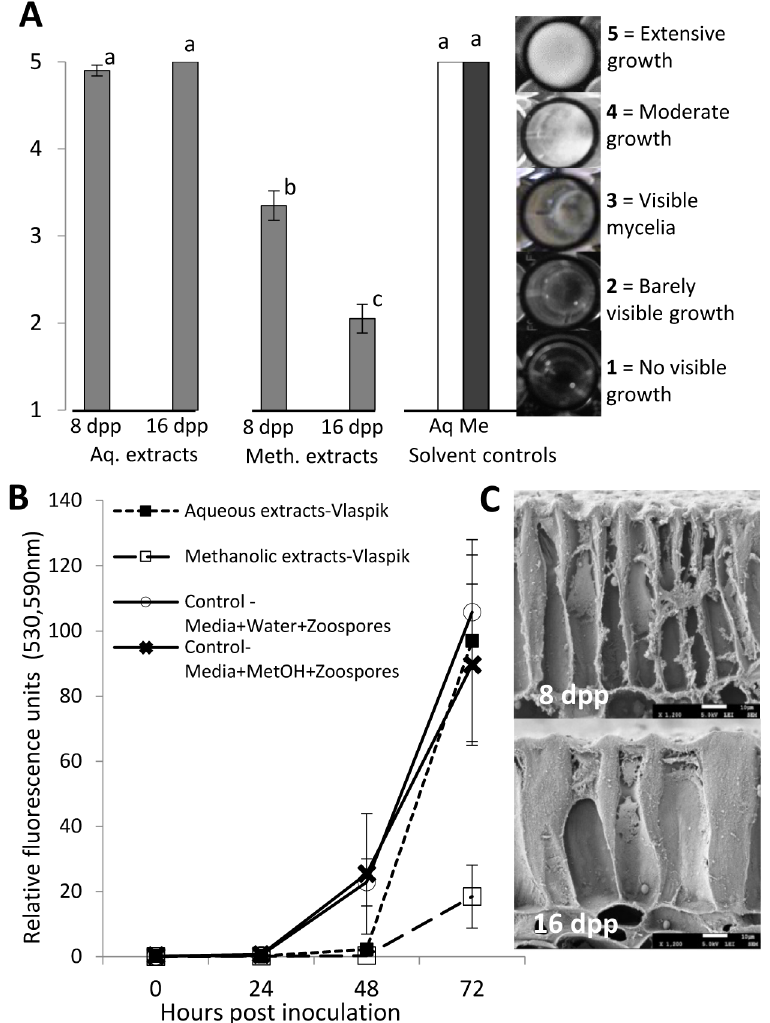
Fig 2. Chemical and physical properties of cucumber fruit peel at 8 and 16 days post pollination (dpp). (A, B) Effect of aqueous and methanolic extracts from cucumber fruit peel on growth of Phytophthora capsici in vitro . Media in individual wells were treated with 10 μ l methanolic or aqueous extracts of cucumber fruit peel or solvent controls prepared as described in methods and inoculated with 20 μ l of zoospores at 10 5 zoospores ml -1 . (A) Visual growth rating of isolate OP97 in response to extracts from 8 dpp and 16 dpp fruit peels, 3 days post inoculation. Rating was based on a 1 – 5 scale as illustrated in the sidebar. (B) Fluorescence emission from isolate NY0664-1RFP in response to aqueous and methanolic extracts. Each value is the mean of 4 – 5 replicate samples ± S.E. Bars marked with different letters are significantly different (LSD, P < 0.05). Each experiment was performed twice with equivalent results. (C) Surface of cucumber fruit at 8 and 16 dpp. Magnification = 1200x; white bar = 10